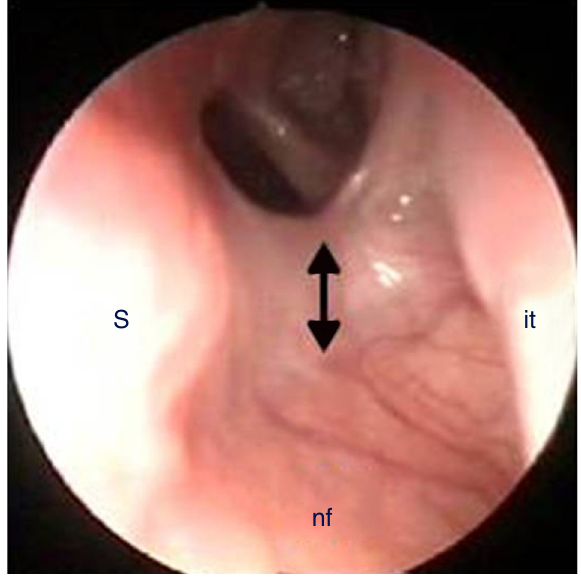
Partial restenosis on the nasal floor (arrow). S, sep- tum; it, inferior turbinate; nf, nasal